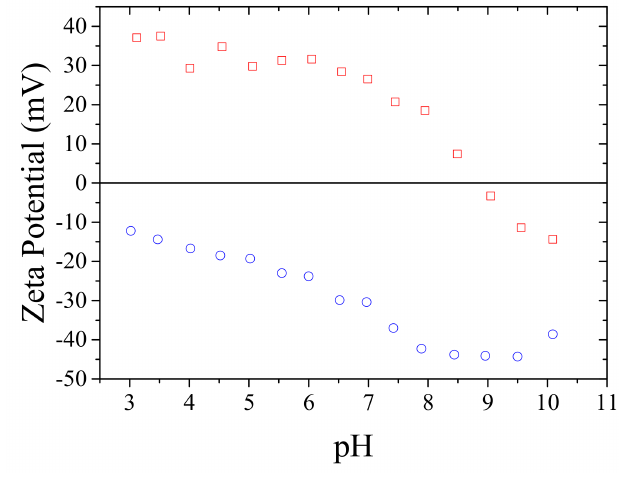
Figure 3. The zeta potential of the PMAC 2 NP 2 ( (cid:3) ) and HPMAC 2 NP 2 ( the solution